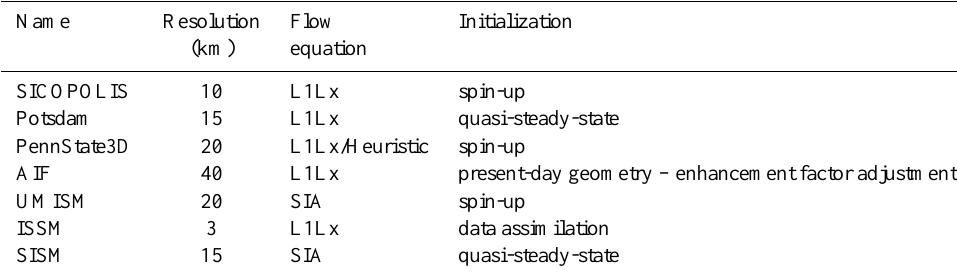
Table 1. Essential characteristics of Antarctic SeaRISE models together with SISM. More details on the numerics can be fund in Bindschadler et al.